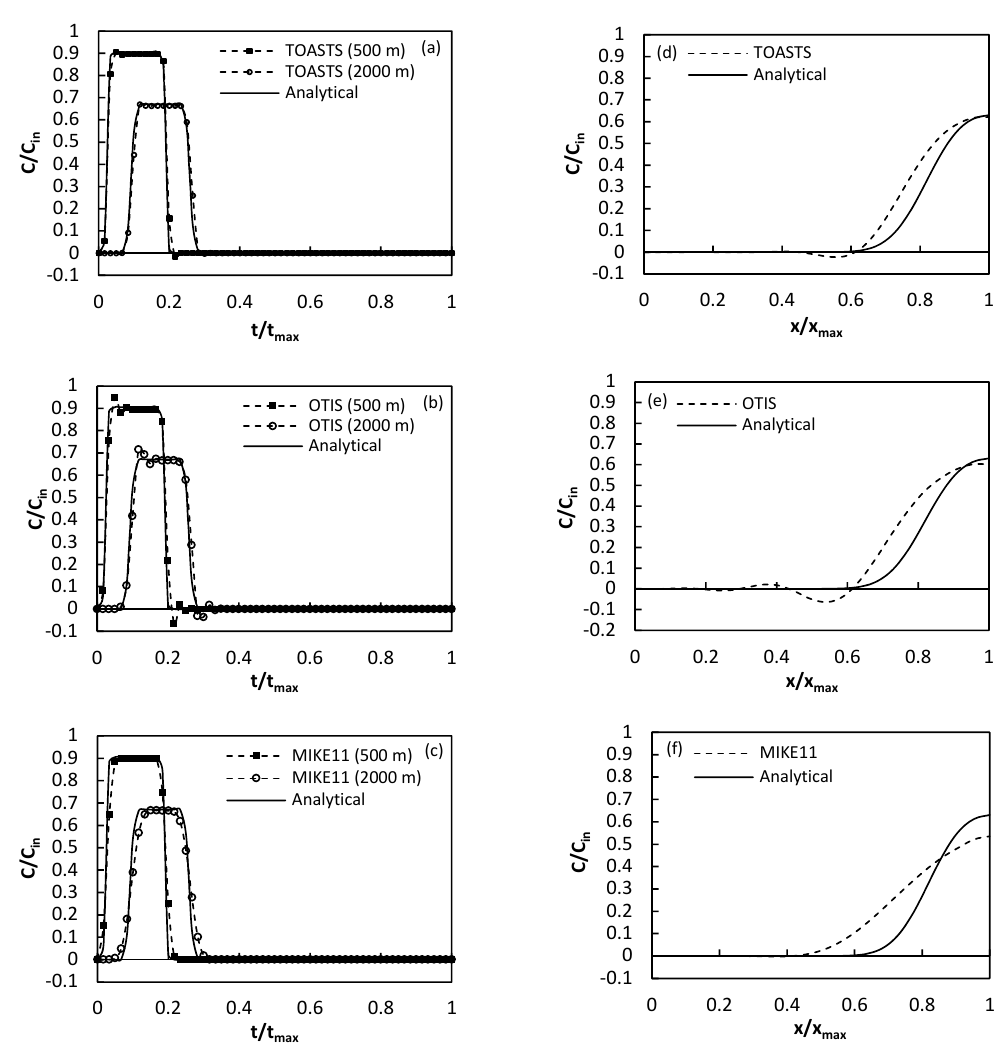
Figure 11. Comparison of the TOASTS, OTIS and MIKE 11 models in test case 2 for Pe = 10. − C n C n + 1 S S (cid:49)t